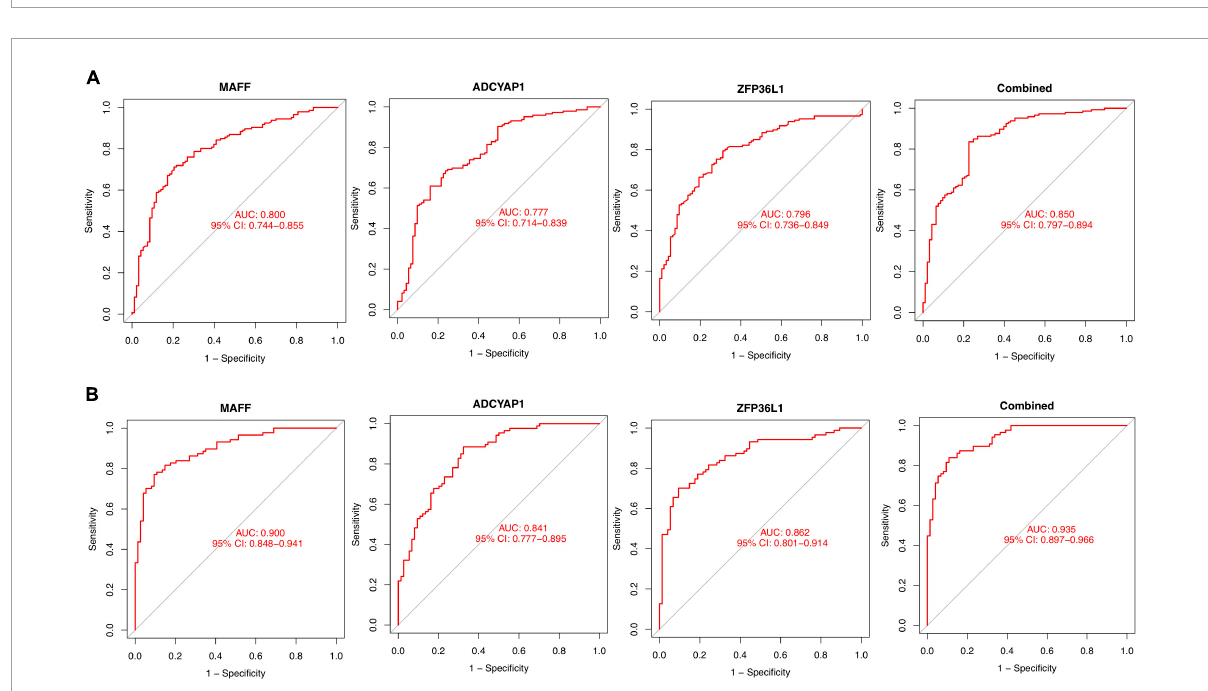
FIGURE6 Diagnostic effectiveness of feature biomarkers. (A) Receiver operating curve (ROC) curves of candidate biomarkers (MAFF, ADCYAP1, ZFP36L1, and combined) in the training cohort. (B) ROC curves of candidate biomarkers (MAFF, ADCYAP1, ZFP36L1, and combined) in the validation